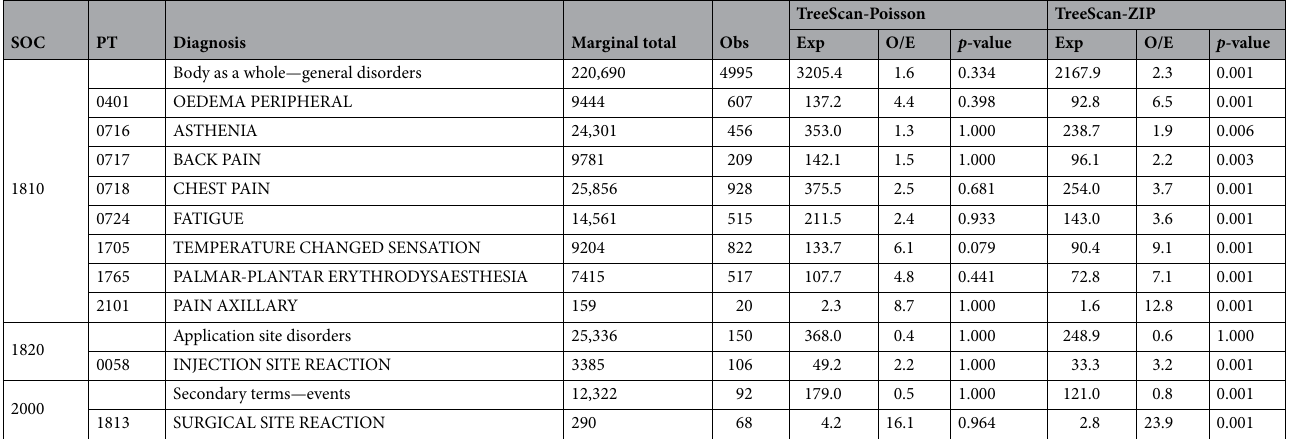
Table 4. Results of signal detection of adverse events of docetaxel by the two